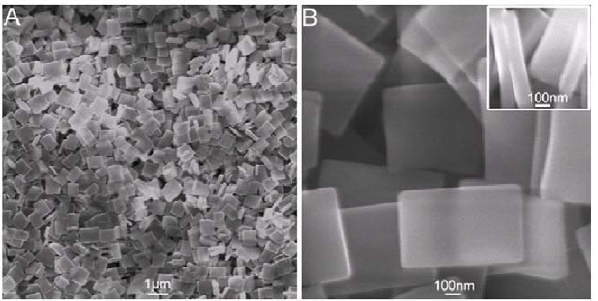
Figure 1. Instrumental analysis of the precipitate thus formed. (A) Low and (B) high magnification SEM images of the precipitates thus formed. Inset shows that the nanoplate is about 100 nm in thickness.